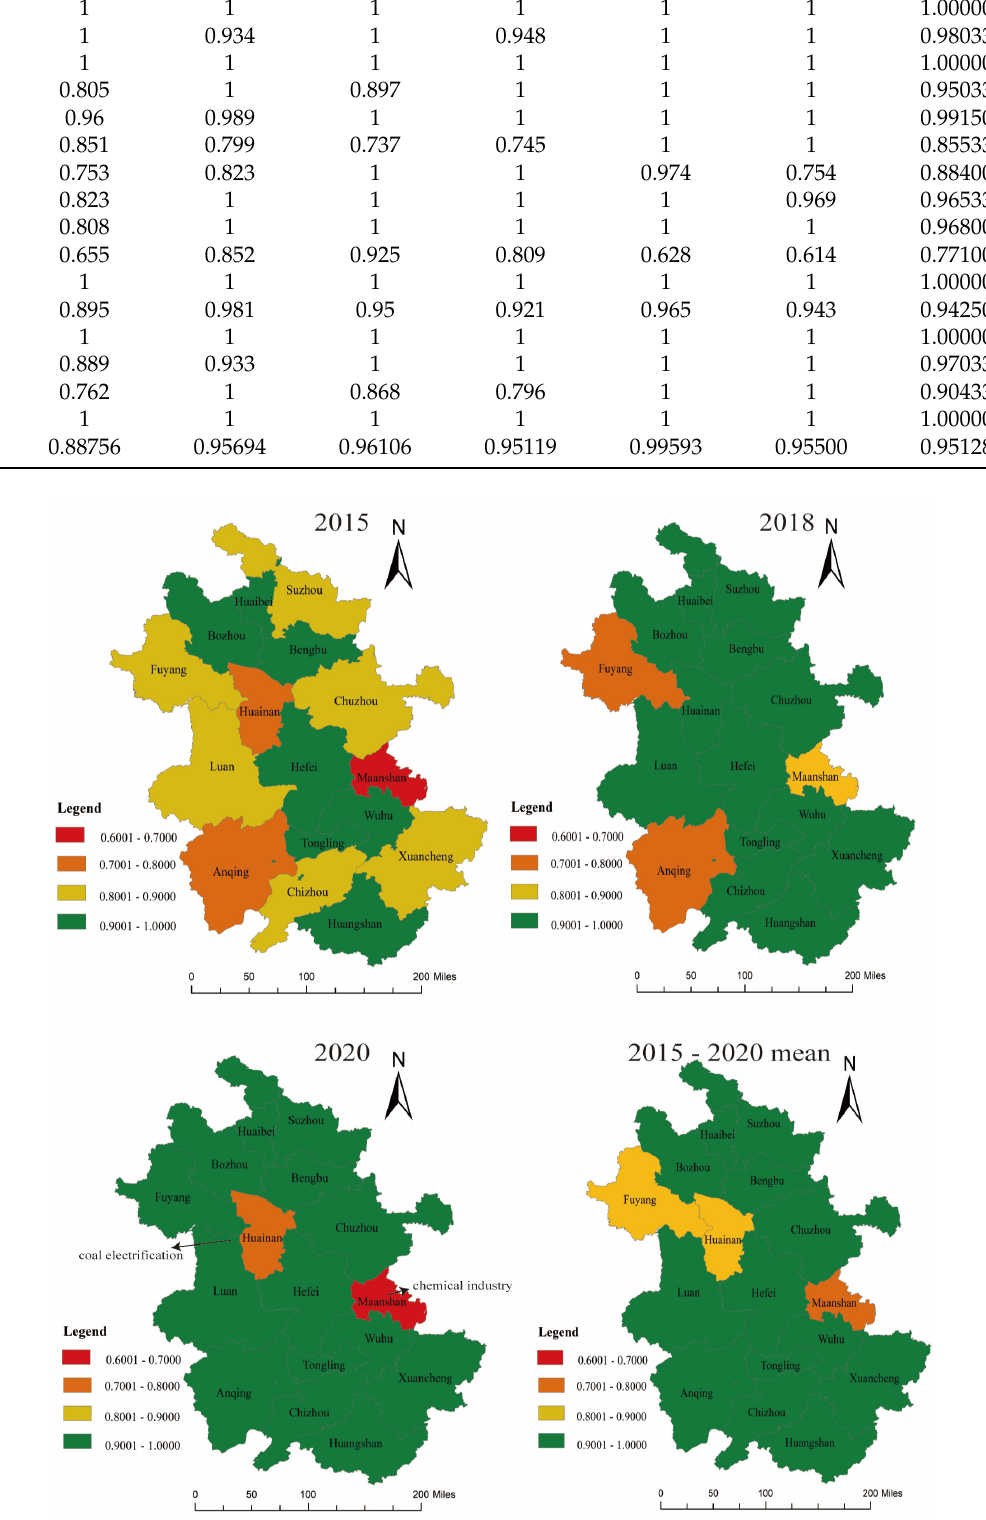
Figure 2. Comparison of mean comprehensive efficiency of Anhui Province in different years.